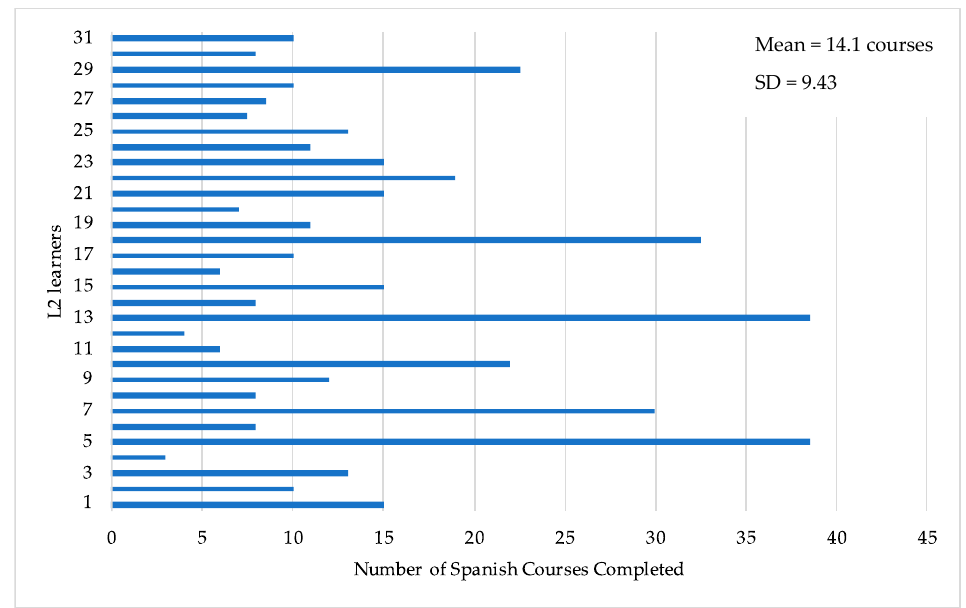
Figure 7. Number of Spanish courses completed by the L2 learners of Spanish. Table 8. Parameter estimates for L2 learners’ comprehension of passives by modality and instruction.